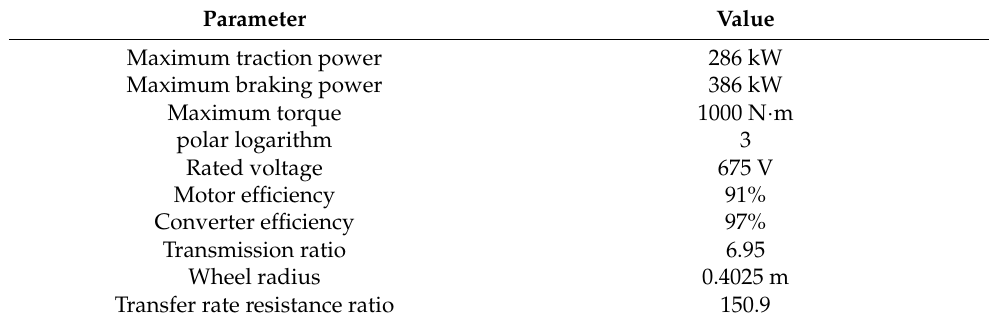
Table 2. Parameters of traction